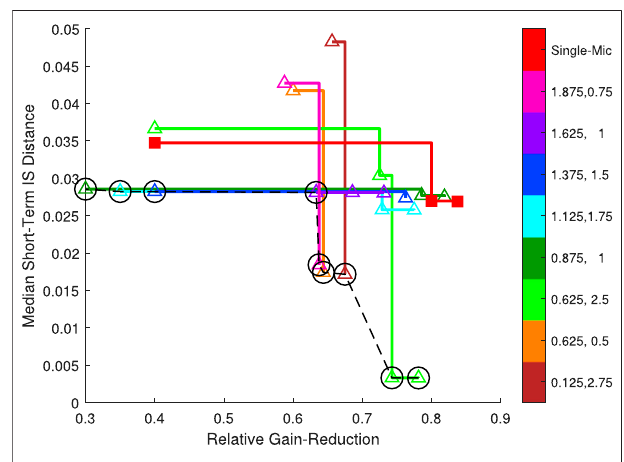
FIGURE 7 | Pareto anti-fronts of the worst-case Pareto-front mic2- locations (connected colored triangles, see color-bar) and of the single- microphone solution (connected red squares). The worst-case Pareto front is depictedbydashed-lineconnectedblackcircles.Bothaxesareaimedto be